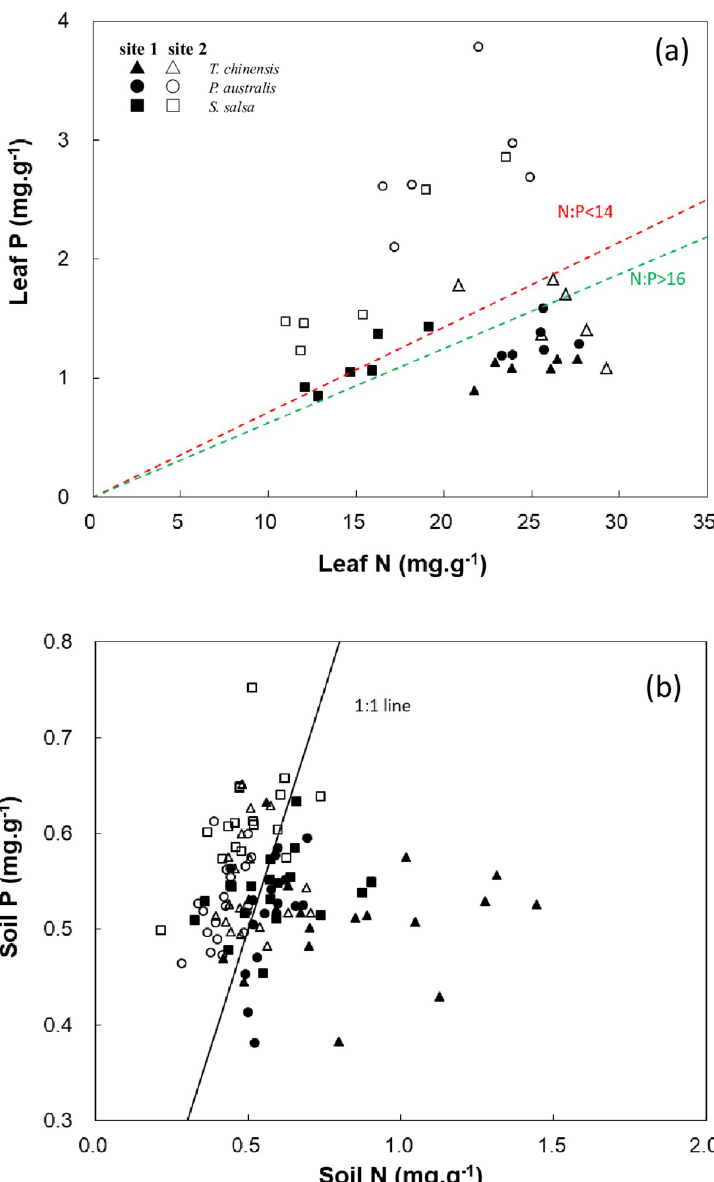
Fig 9. Relationships between N and P of plants and soils. (a) N versus P of plants; (b) N versus P of soils.